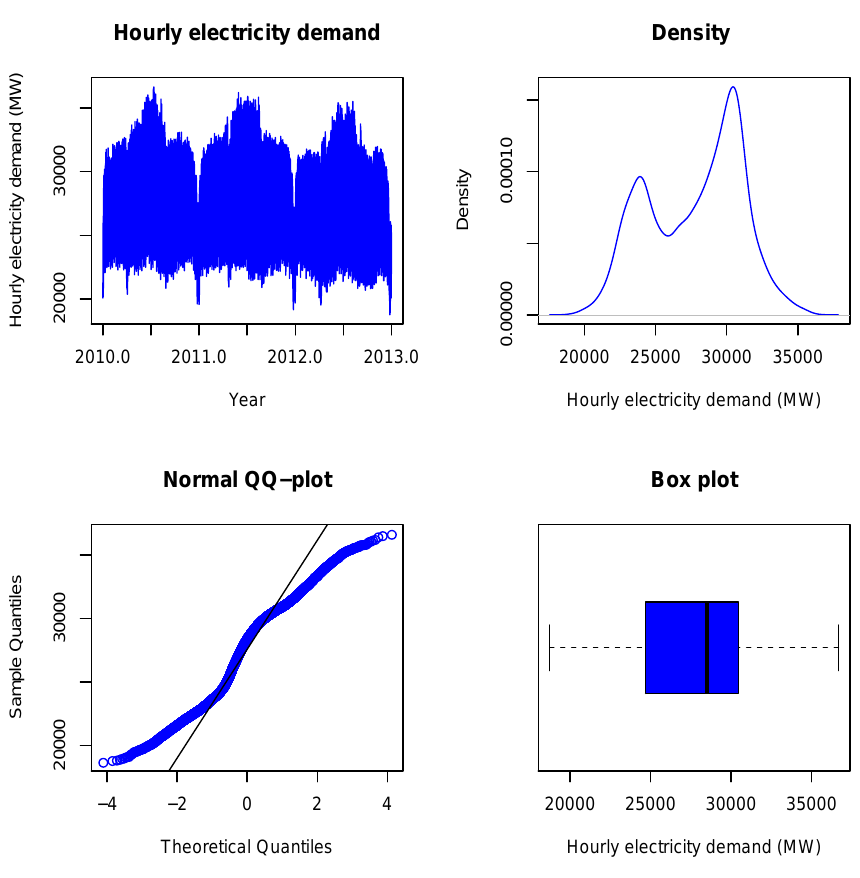
Figure 1. Hourly electricity demand from January 2010 to 31 December